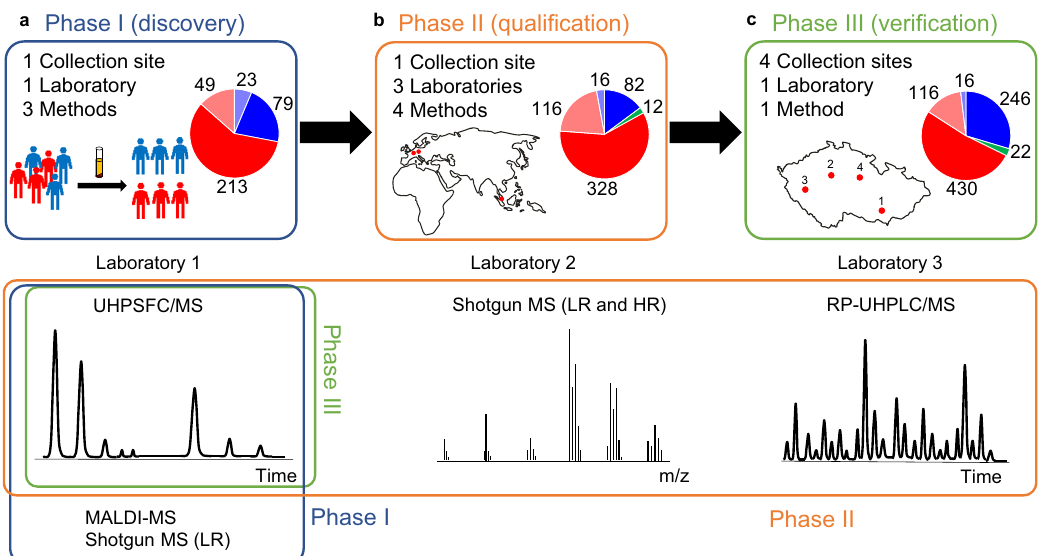
Fig. 1 Overview of study design for the differentiation of PDAC patients (T, red) from normal healthy controls (N, blue) and pancreatitis patients (Pan, green) based on the lipidomic pro fi ling of human serum using various mass spectrometry-based approaches. a Phase I (discovery) for 364 samples (262 T + 102 N) divided into training (213 T + 79 N) and validation (49 T + 23 N) sets measured by UHPSFC/MS, shotgun MS (LR), and MALDI-MS. b Phase II (quali fi cation) for 554 samples (444 T + 98 N + 12 Pan) divided into training (328 T + 82 N + 12 Pan) and validation (116 T + 16 N) sets measured by UHPSFC/MS, shotgun MS (LR and HR), and RP-UHPLC/MS at 3 different laboratories. c Phase III (veri fi cation) for 830 samples (546 T + 262 N + 22 Pan) divided into training (430 T + 246 N + 22 Pan) and validation (116 T + 16 N) sets measured by UHPSFC/MS for samples obtained from four collection sites.